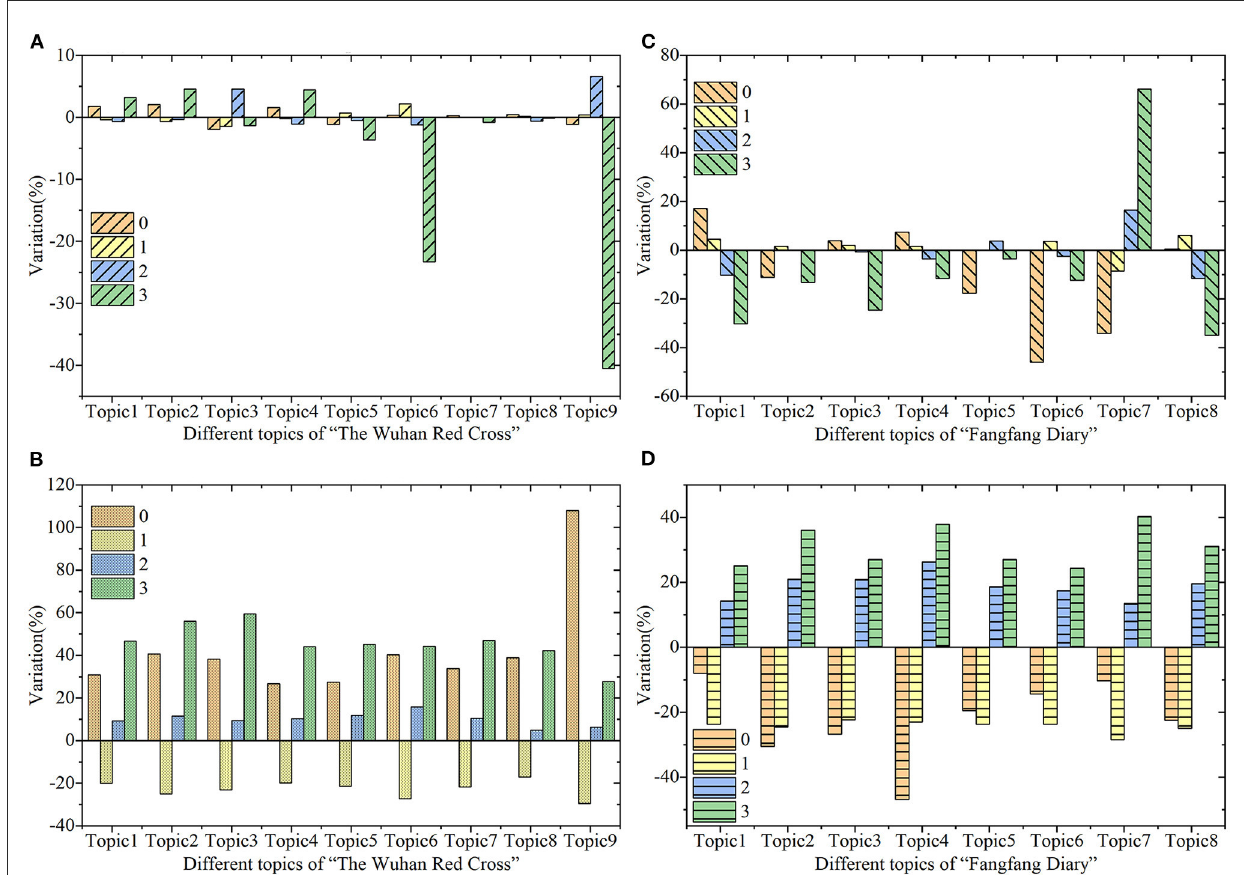
FIGURE5 The percentage variation of the topics content proportion, difference of four levels public sentiments in different topics. (A) The variation of the Weibo posts in “The Wuhan Red Cross”. (B) The variation of the Weibo comments in “The Wuhan Red Cross”. (C) The variation of the Weibo posts in “Fangfang Diary”. (D) The variation of the Weibo comments in “Fangfang